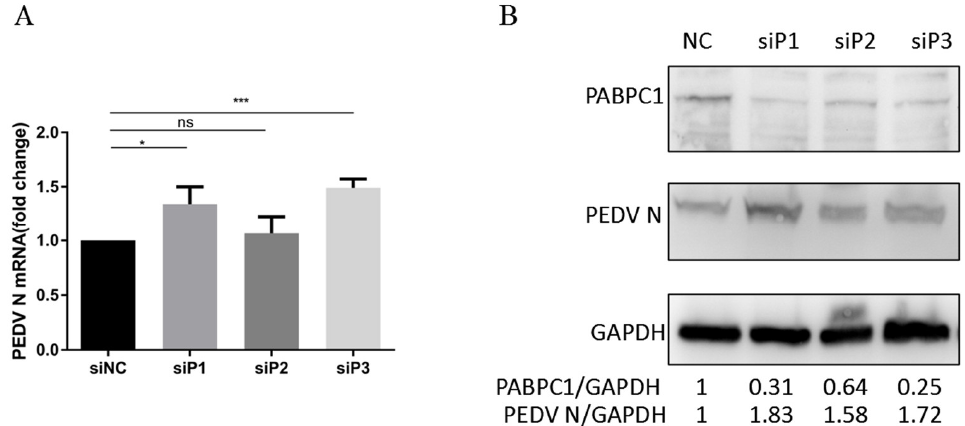
Figure 3. Knockdown of PABPC1 expression by siRNA promotes PEDV replication in Vero cells. ( A ) The changes in N -gene expression after the knockdown of PABPC1 by siRNA. ( B ) The changes in N-protein expression after the knockdown of PABPC1 by siRNA. * means p < 0.05; *** means p < 0.001, ns means p > 0.05.